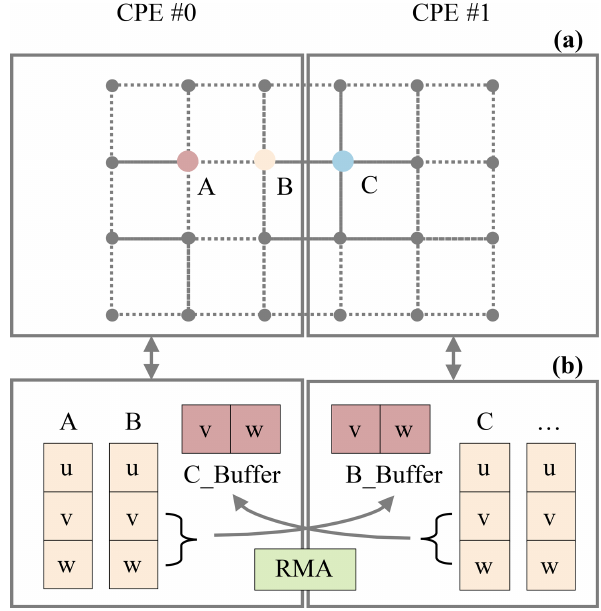
Figure 4. Tensor distribution in different CPEs (a) and data trans- portation between CPEs (b)